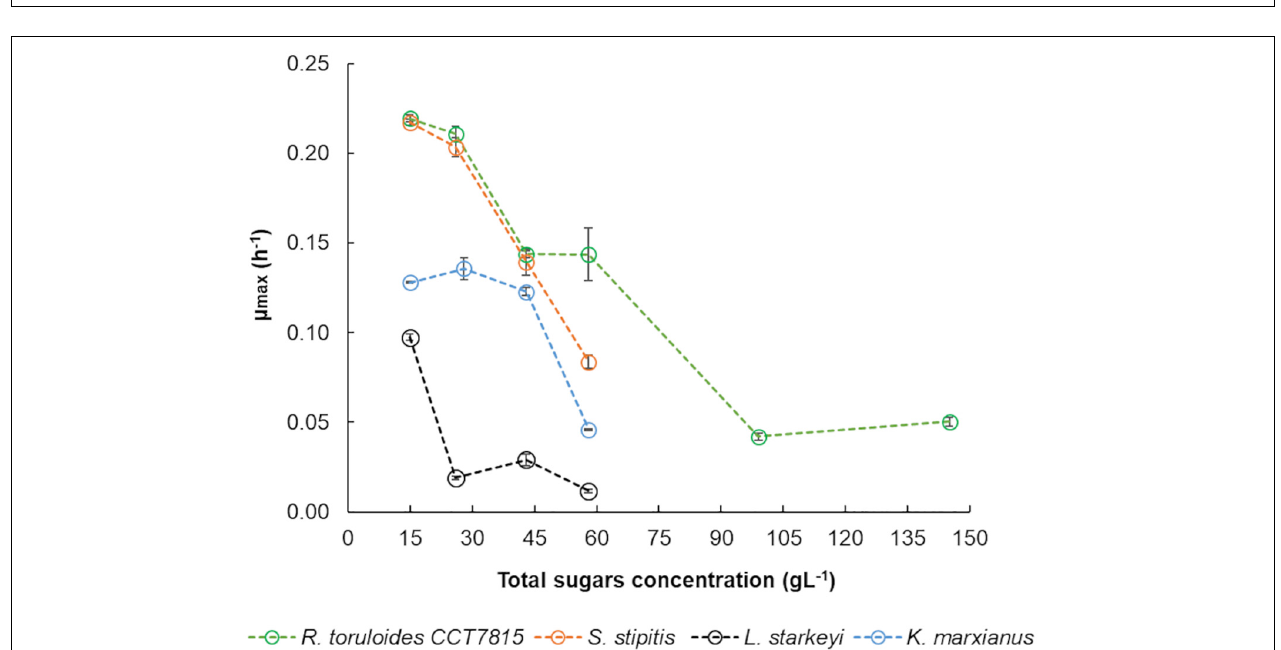
FIGURE 1 | (A) Growth profile of all 9 yeast strains in C5-Birch hydrolysate. The OD was acquired every 30 min and the curves represent the average of at least 3 replicates, Supplementary Table 1 comprises all obtained profiles. (B) Heatmap of maximum achieved OD, length of lag phase, and specific growth rate for the different strains cultivated in C5-Birch hydrolysate with 10 gL − 1 xylose plus glucose. White is used when no data is available. Data is ranked from the highest to lowest µ max in the second growth phase, representing growth on xylose. Numeric data for generating the heatmap can be found in Supplementary Table 2 .